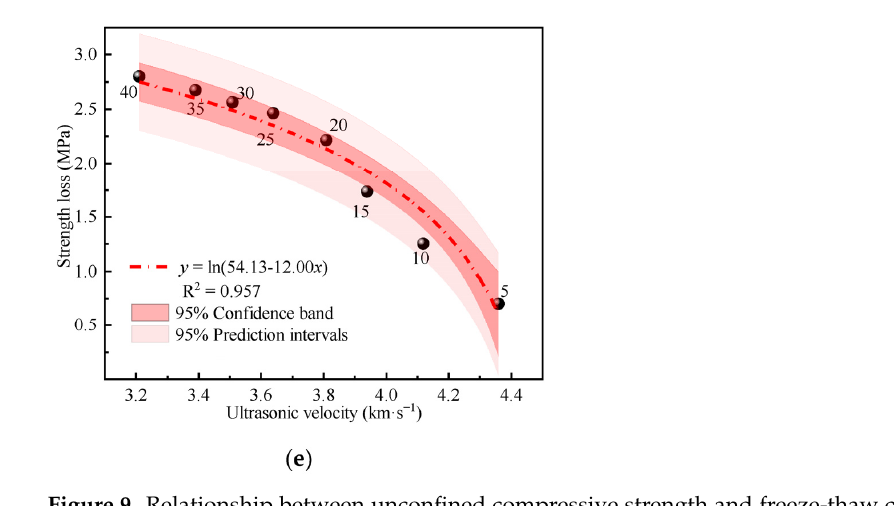
Figure 9. Relationship between unconfined compressive strength and freeze-thaw cycle: ( a ) CFR- BCA1, ( b ) CFRBCA2, ( c ) CFRBCA3, ( d ) CFRBCA4, ( e )